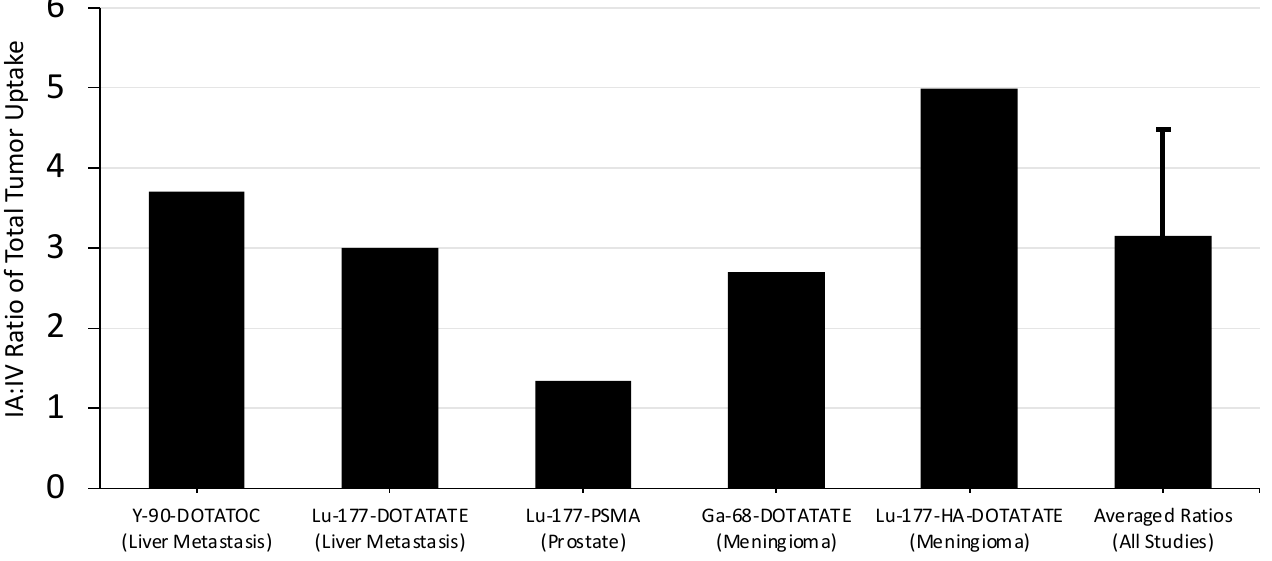
Figure 4. Summary of findings comparing IA and IV delivery of radiopharmaceuticals to tumors. The ratios from all studies were averaged, and the standard deviation of the average is reported here. The authors of the corresponding studies are as follows: Kratochwil et al. (Y-90-DOTATOC) [40], Thakral et al. (Lu-177-DOTATATE) [42], Sayman et al. (Lu-177-PSMA) [43], Verburg et al. (Ga-